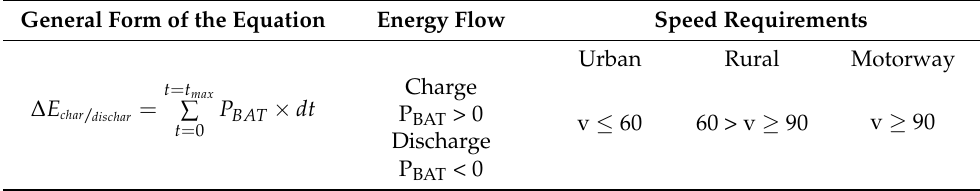
Table 6. Vehicle motion phase criteria